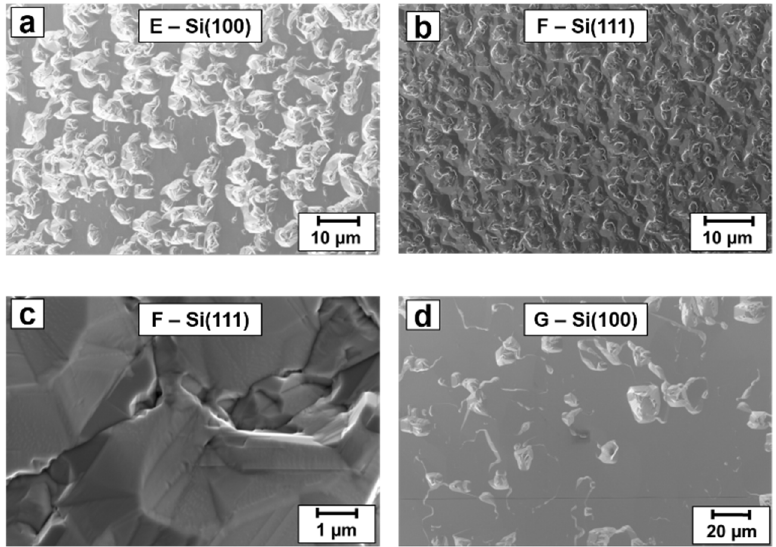
Figure 2. SEM images showing ( a ) GaP/Si(100) sample E; ( b ) GaP/Si(111) sample F; ( c ) close-up of sample F shown in ( b ); ( d ) GaP/Si(100) sample G.